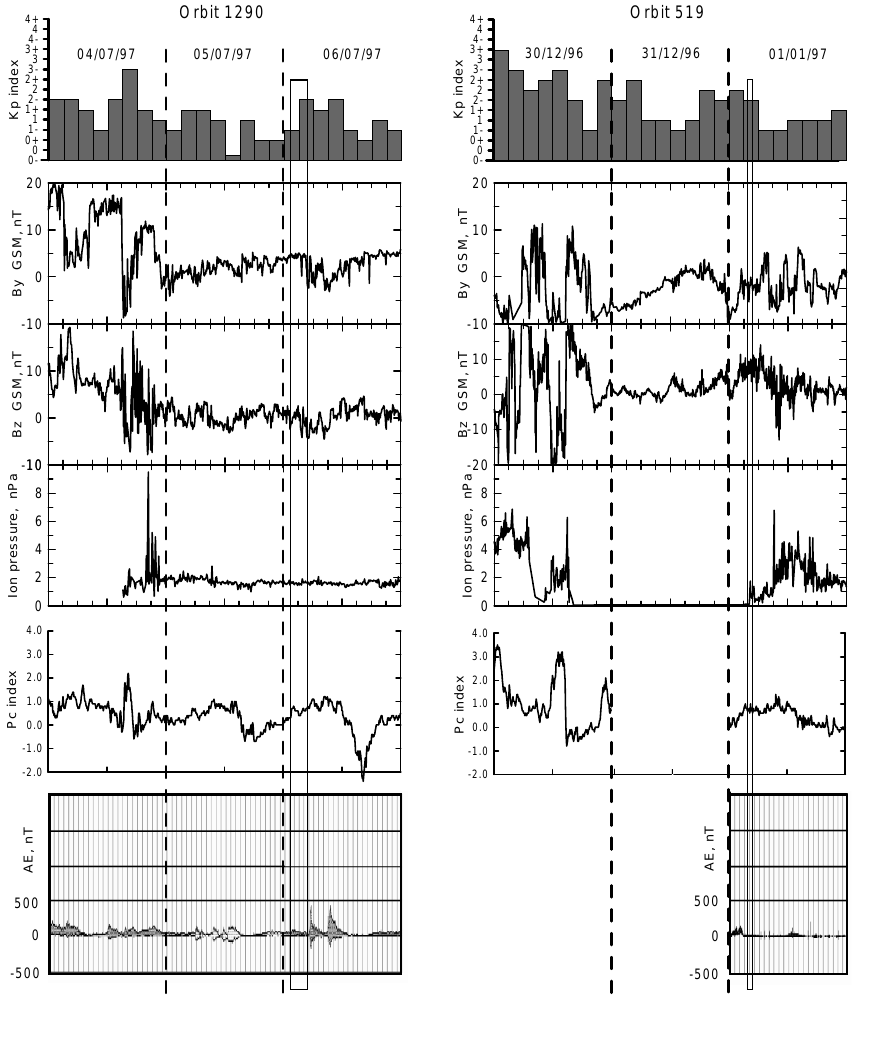
Fig. 3. The same as Fig. 2 for 4–6 July 1997 (left column) and 30 Decem- ber 1996 to 01 January 1997 (right col-